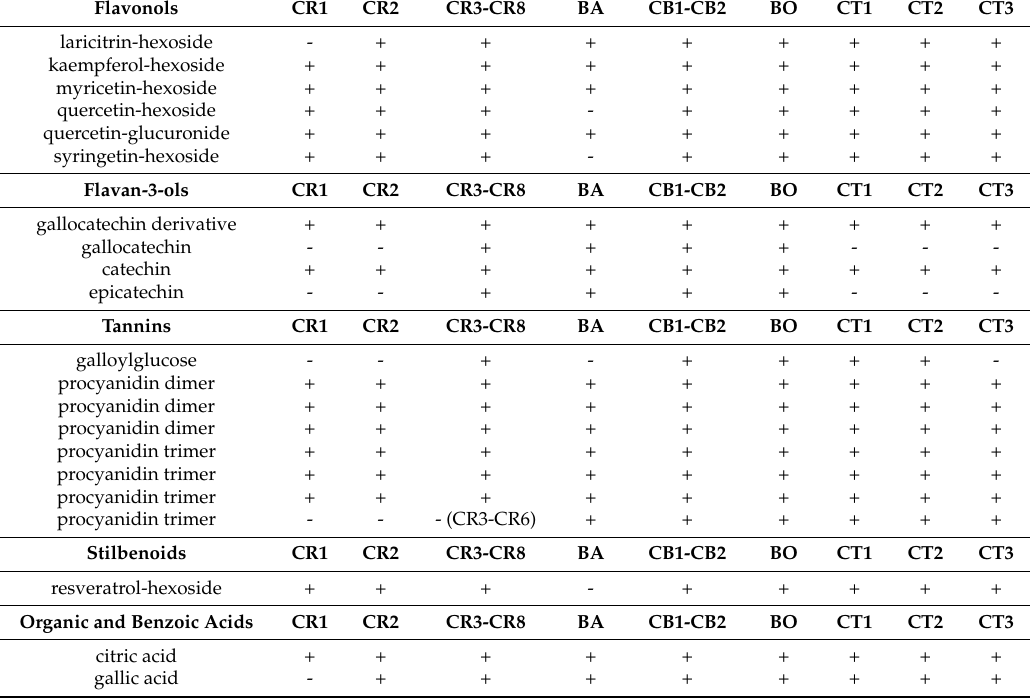
Table 3. Presence (+) or absence (-) of the identified flavonols, flavan-3-ols, tannins, stilbenoids, benzoic and organic acids in the 15 wine